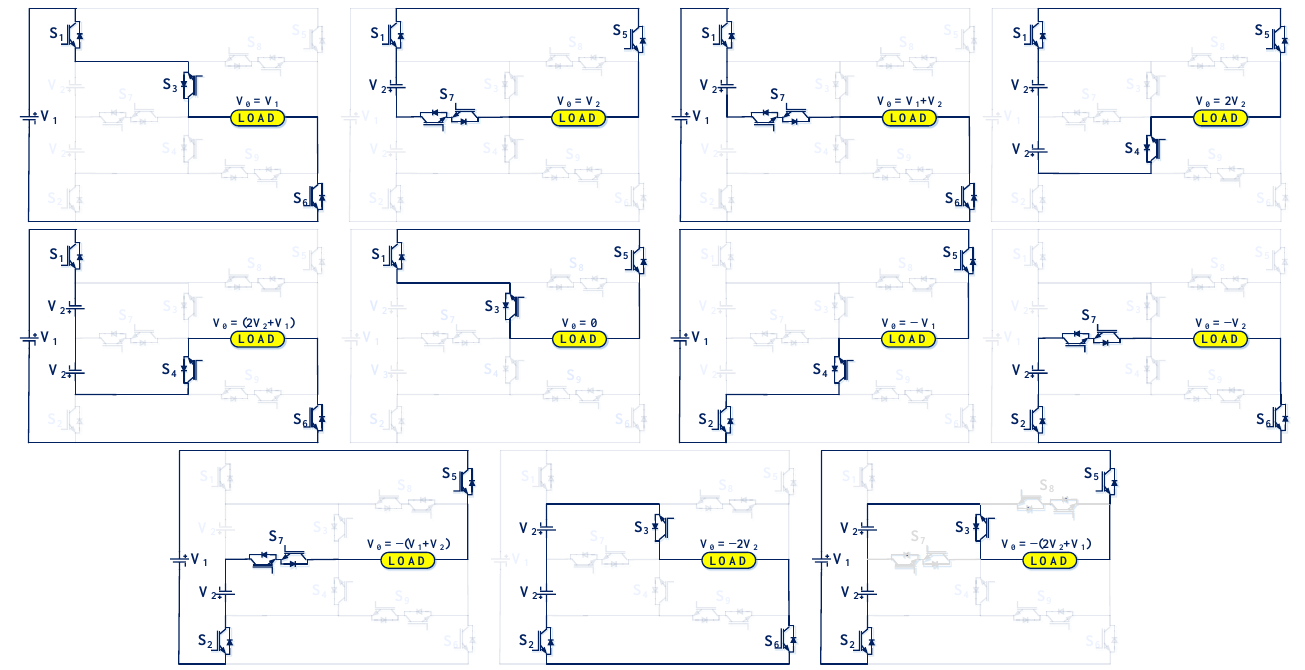
Figure 2. Conduction states during healthy operation.